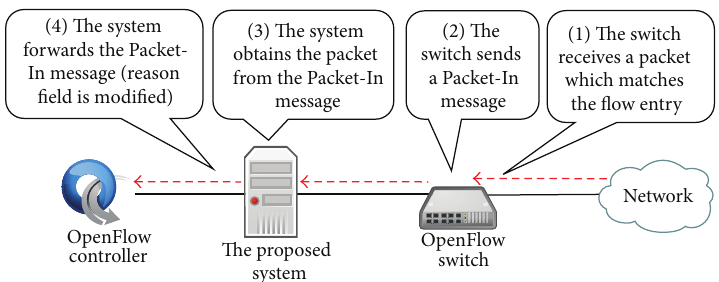
Figure 7: The behavior of capture module in the case of Packet-In message reception from the OpenFlow switch.